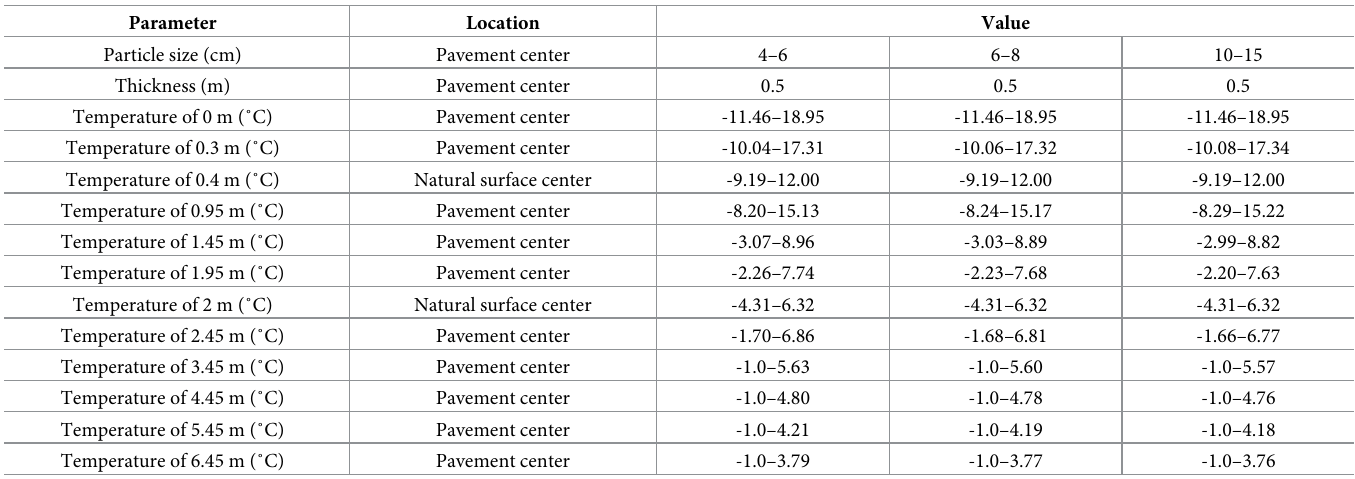
Table 10. Temperature of varied subbase